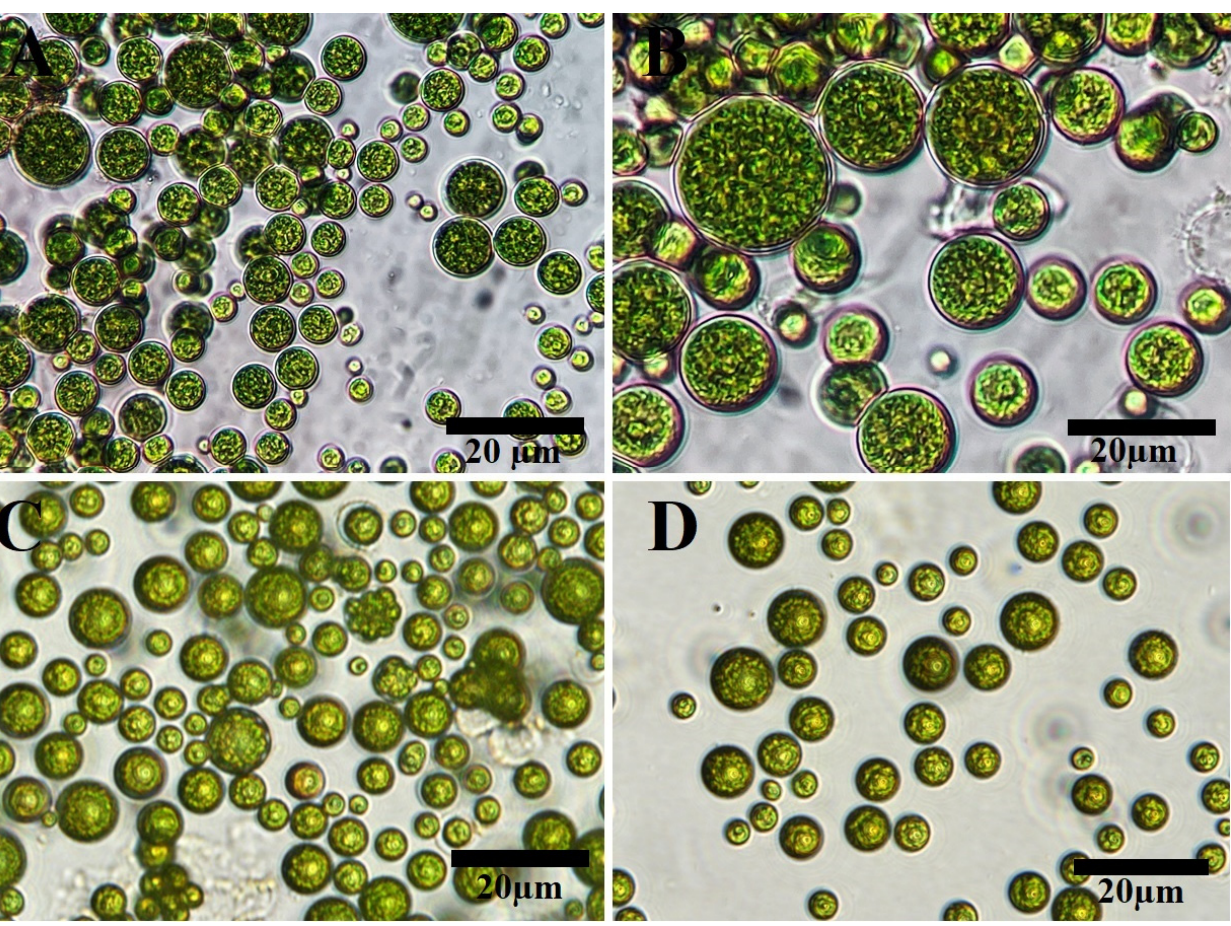
Figure 1. Light ( A , B ) and inverted light ( C , D ) microscopy of unicellular ulvophyte sp. MBIC10591. Scale bar = 20 μ m.